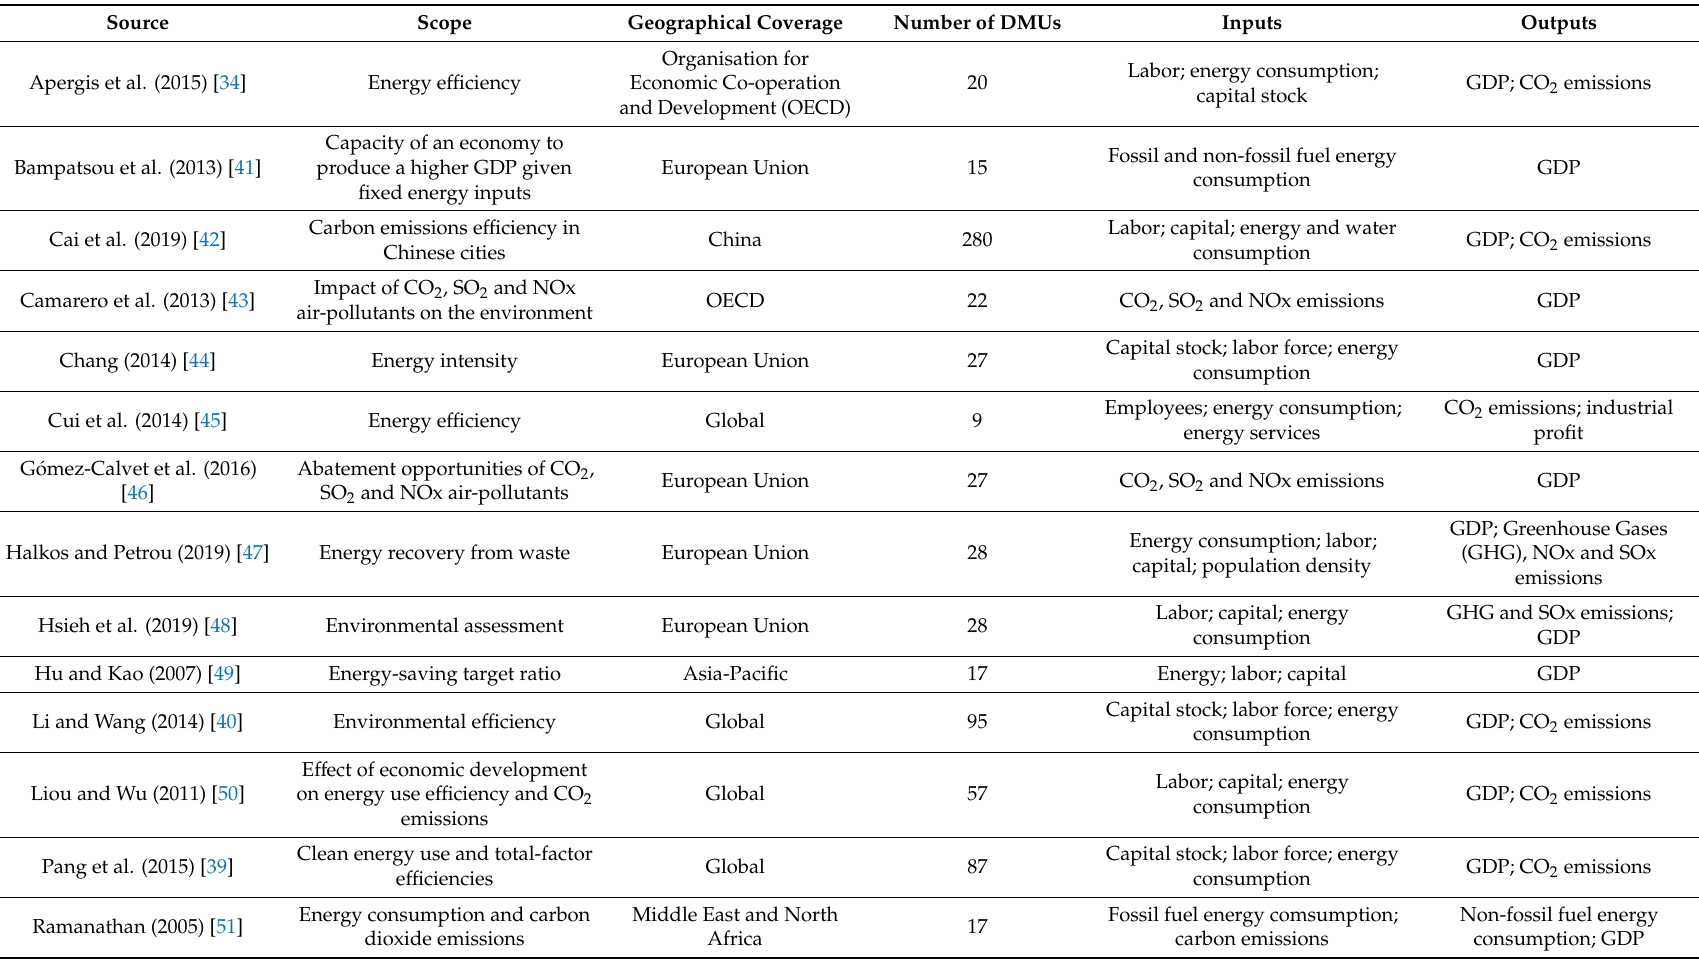
Table 1. Literature review of publications using data envelopment analysis (DEA) to analyze energy-related